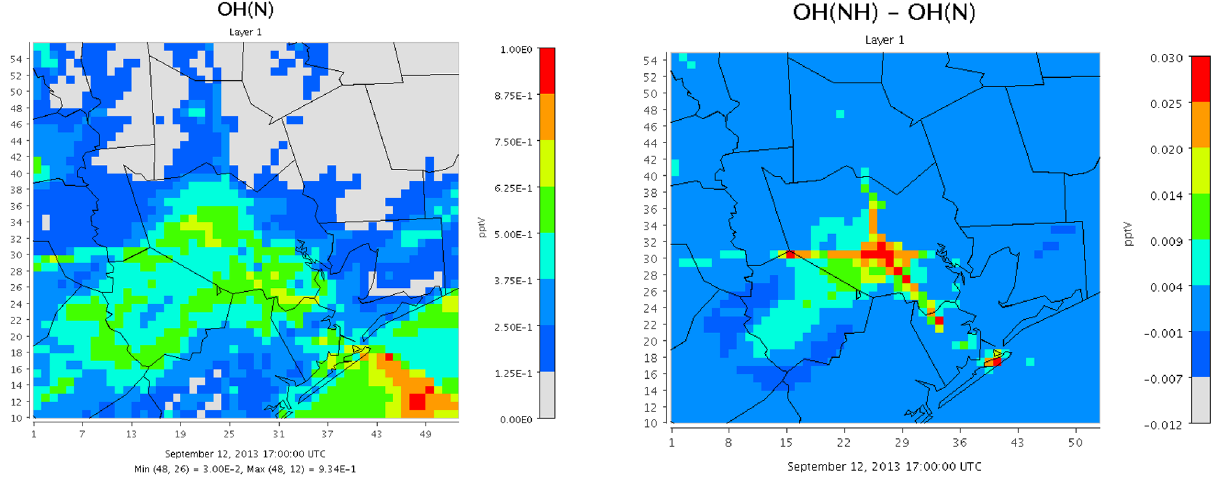
Figure 8. OH mixing ratios (left) and differences in OH mixing ratios (right) between the case with 0.008 HONO / NO x emission ratio (N) and 0.016 HONO/NO x emission ratio (NH) at noon local time on 12 September 2013.